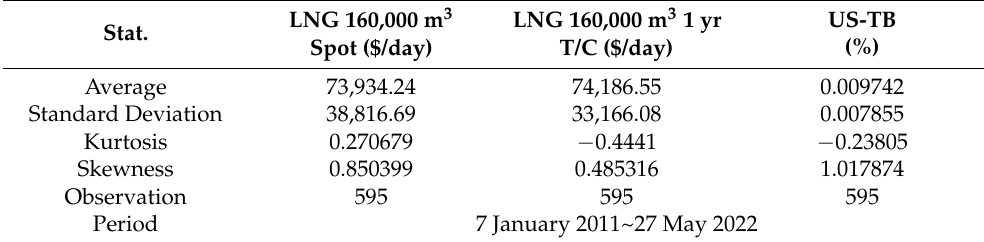
Table 2. Descriptive statistics of the data. Stat.